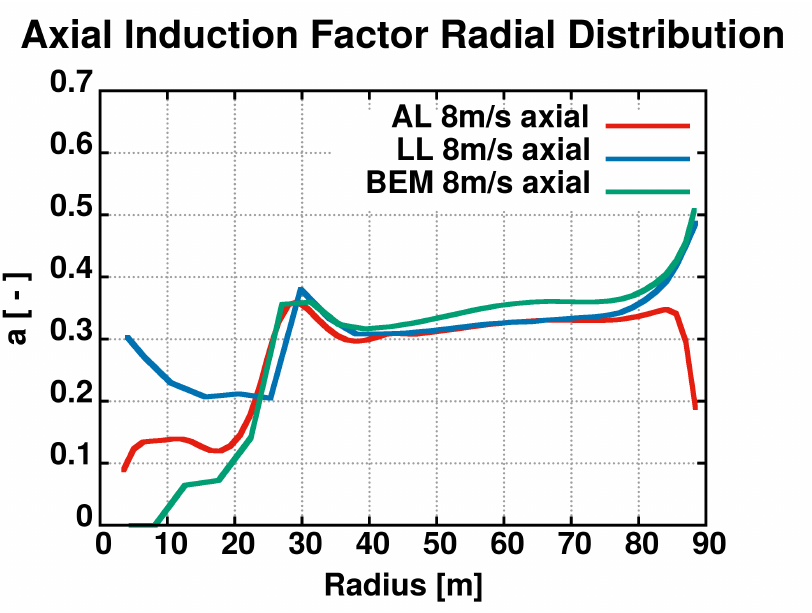
Figure 20. Axial induction factor radial distribution at 8 m/s axial wind speed. Averaging over the final revolution of the